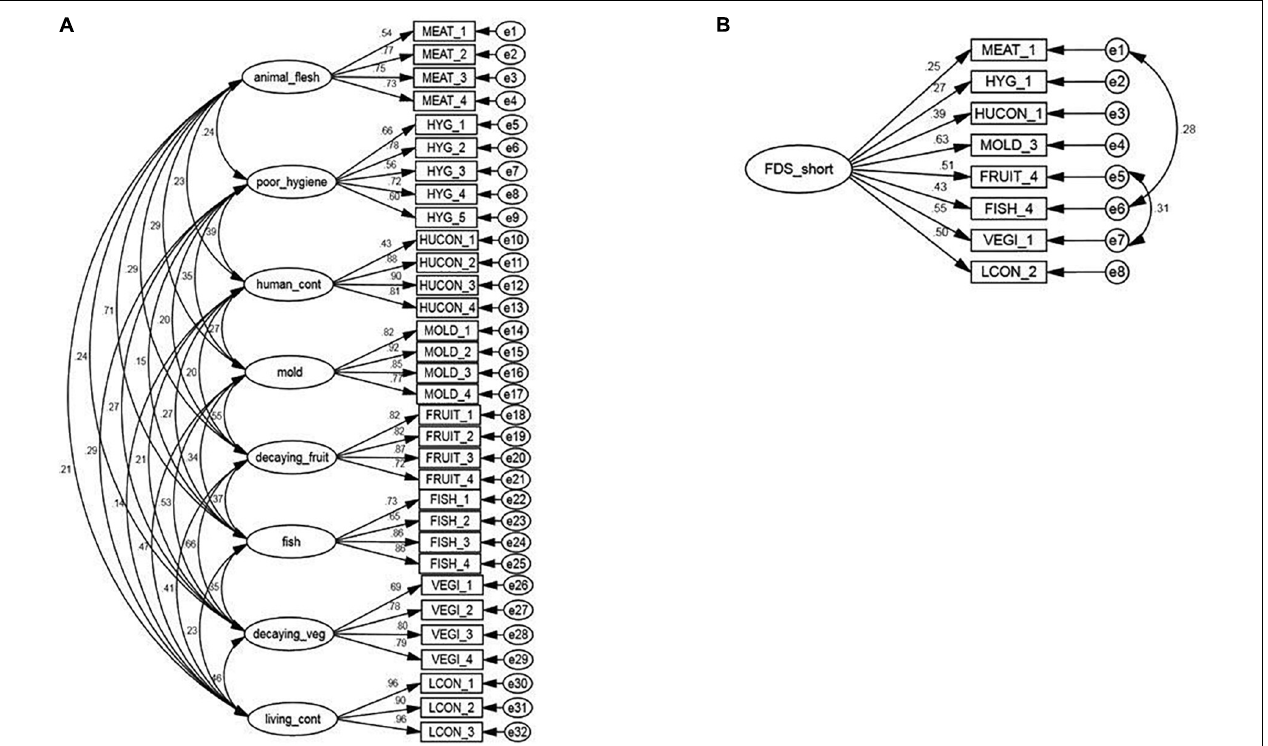
FIGURE 1 | Confirmatory factor analysis models. (A) Eight-factor model for the Food Disgust Scale in Spanish (FDS-Sp). The CFA for 32-item version with eight subscales was consistent: CFI = 0.947, NFI = 0.912, RMSEA = 0.048, χ 2 = 1020.434 ( p -value < 0.001), df = 436. (B) Single factor model for the Food Disgust Scale in Spanish (FDS-Sp). CFA for the short version showed acceptable goodness-of-fit indices: CFI = 0.951, NFI = 0.925, RMSEA = 0.053, χ 2 = 47.903 ( p -value < 0.001), df =